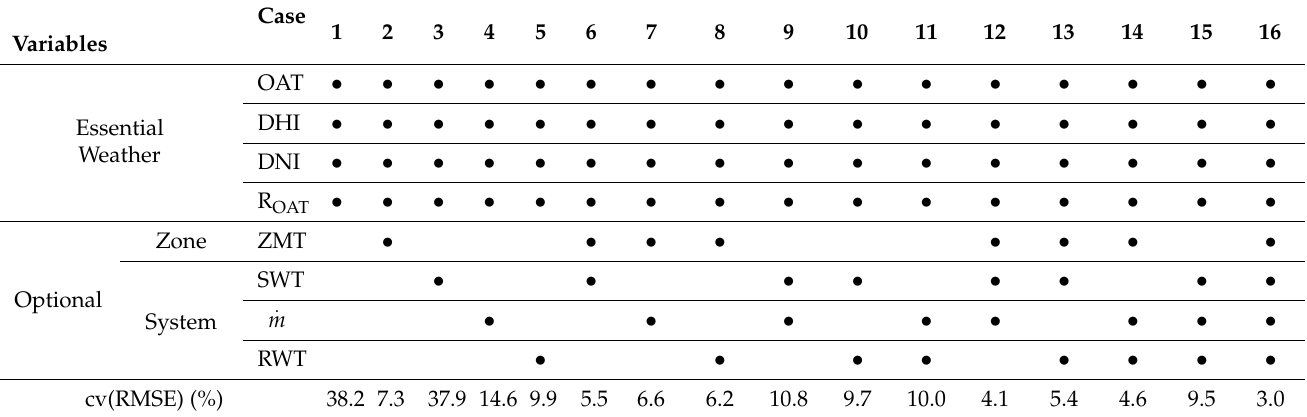
Table 7. Comparison of the heating energy